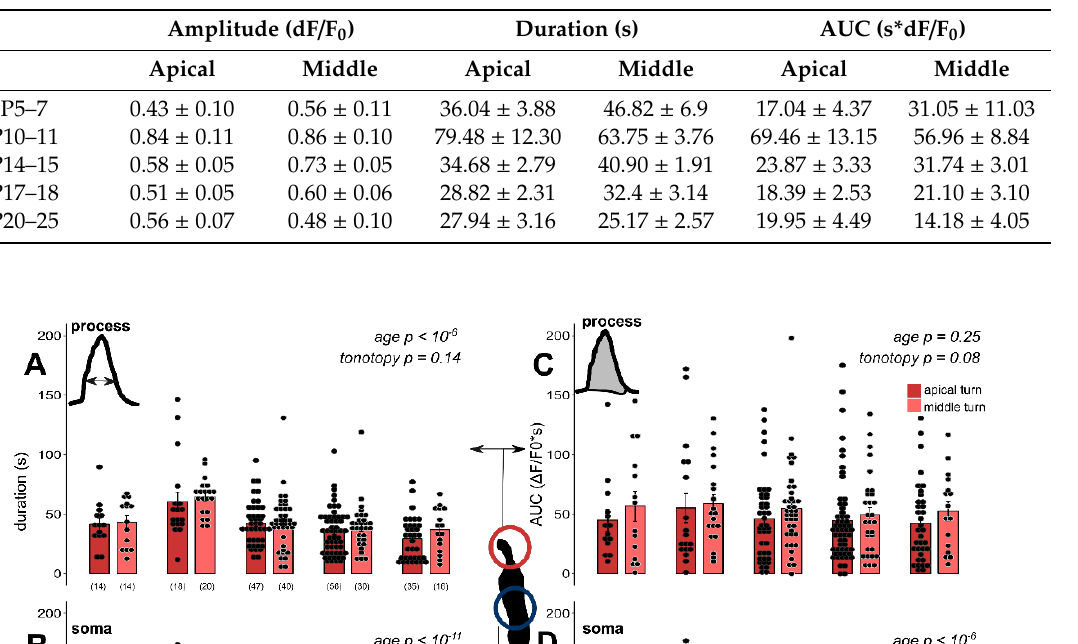
Table 4. Magnitude and kinetic characteristics of ATP (100 µ M) induced Ca 2 + transients in the soma of Deiters’ cells (mean ± SEM).